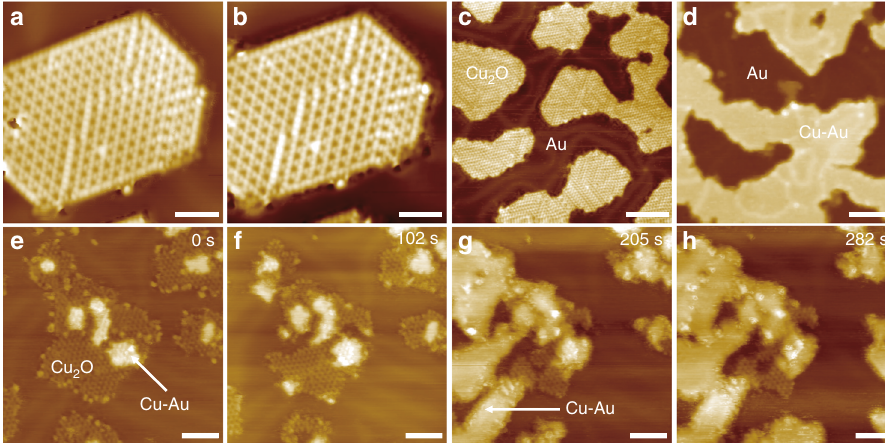
Fig. 3 The adsorption and reaction of CO on Cu 2 O/Au(111). a , b In situ STM images before ( a ) and after ( b ) the exposure of CO on Cu 2 O/Au(111) at 78 K. No adsorption was obvious after the exposure of 18 L CO. c , d Ex-situ and e – h in situ NAP-STM images on the reduction of Cu 2 O on Au(111) in 1 mbar ( d ) or 0.5 mbar ( e – h ) CO at 300 K. The reduction of Cu 2 O NSs led to the formation of a Cu – Au surface alloy. The reaction times were marked at the top right of images. Scanning parameters: a V s = − 2.0 V, I = 0.06 nA; b V s = − 1.7 V, I = 0.03 nA; c V s = 1.1 V, I = 0.09 nA; e V s = 1.2 V, I = 0.02 nA; f V s = 1.2 V, I = 0.05 nA. Scale bars: a , b 2 nm; c , d 10 nm; e – h 5